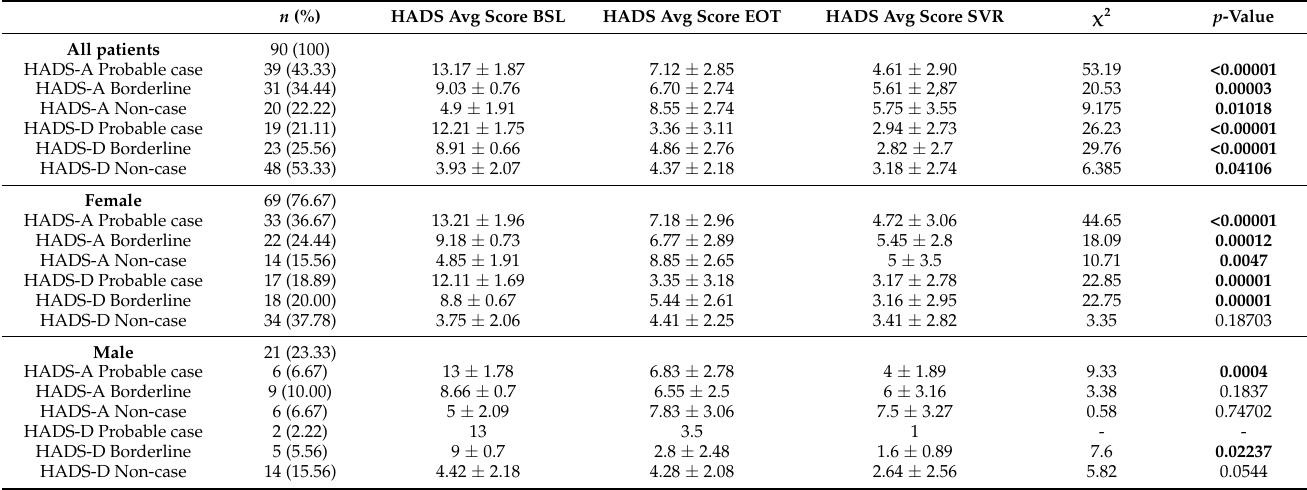
Table 4. Patients’ psychological status during the study period ( χ 2 Friedman test). On the p -Value column, bold is used in order to underline the statistically significant values of p